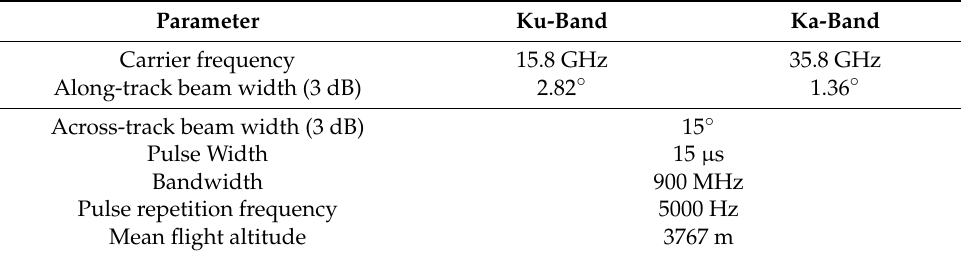
Table 1. The main parameters of the airborne SAR altimeter system.